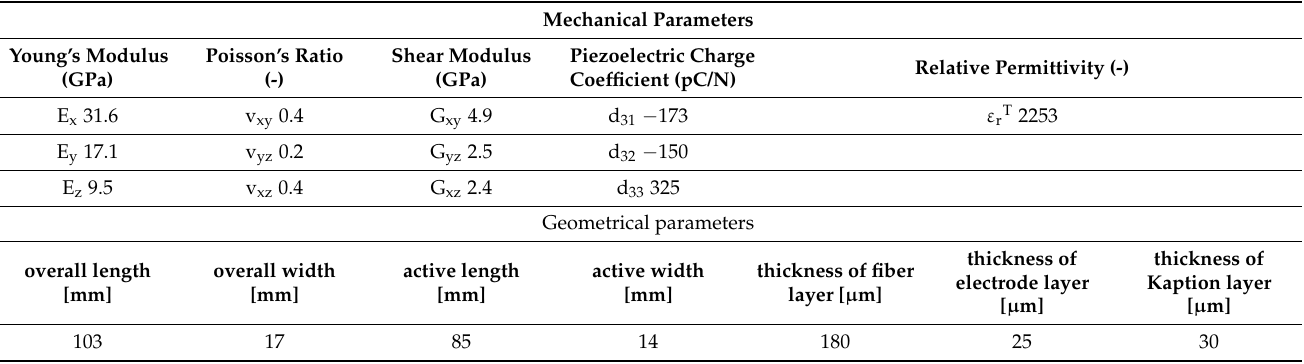
Table 1. Material properties of homogenized MFC layer of MFC8514 P2